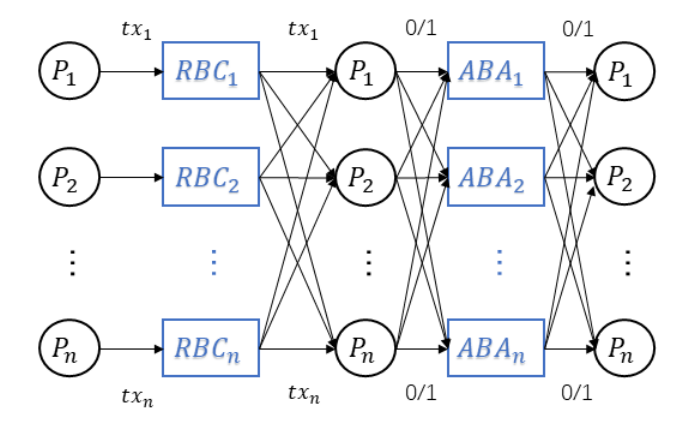
Figure 1. The structure of the main building blocks in HB-BFT